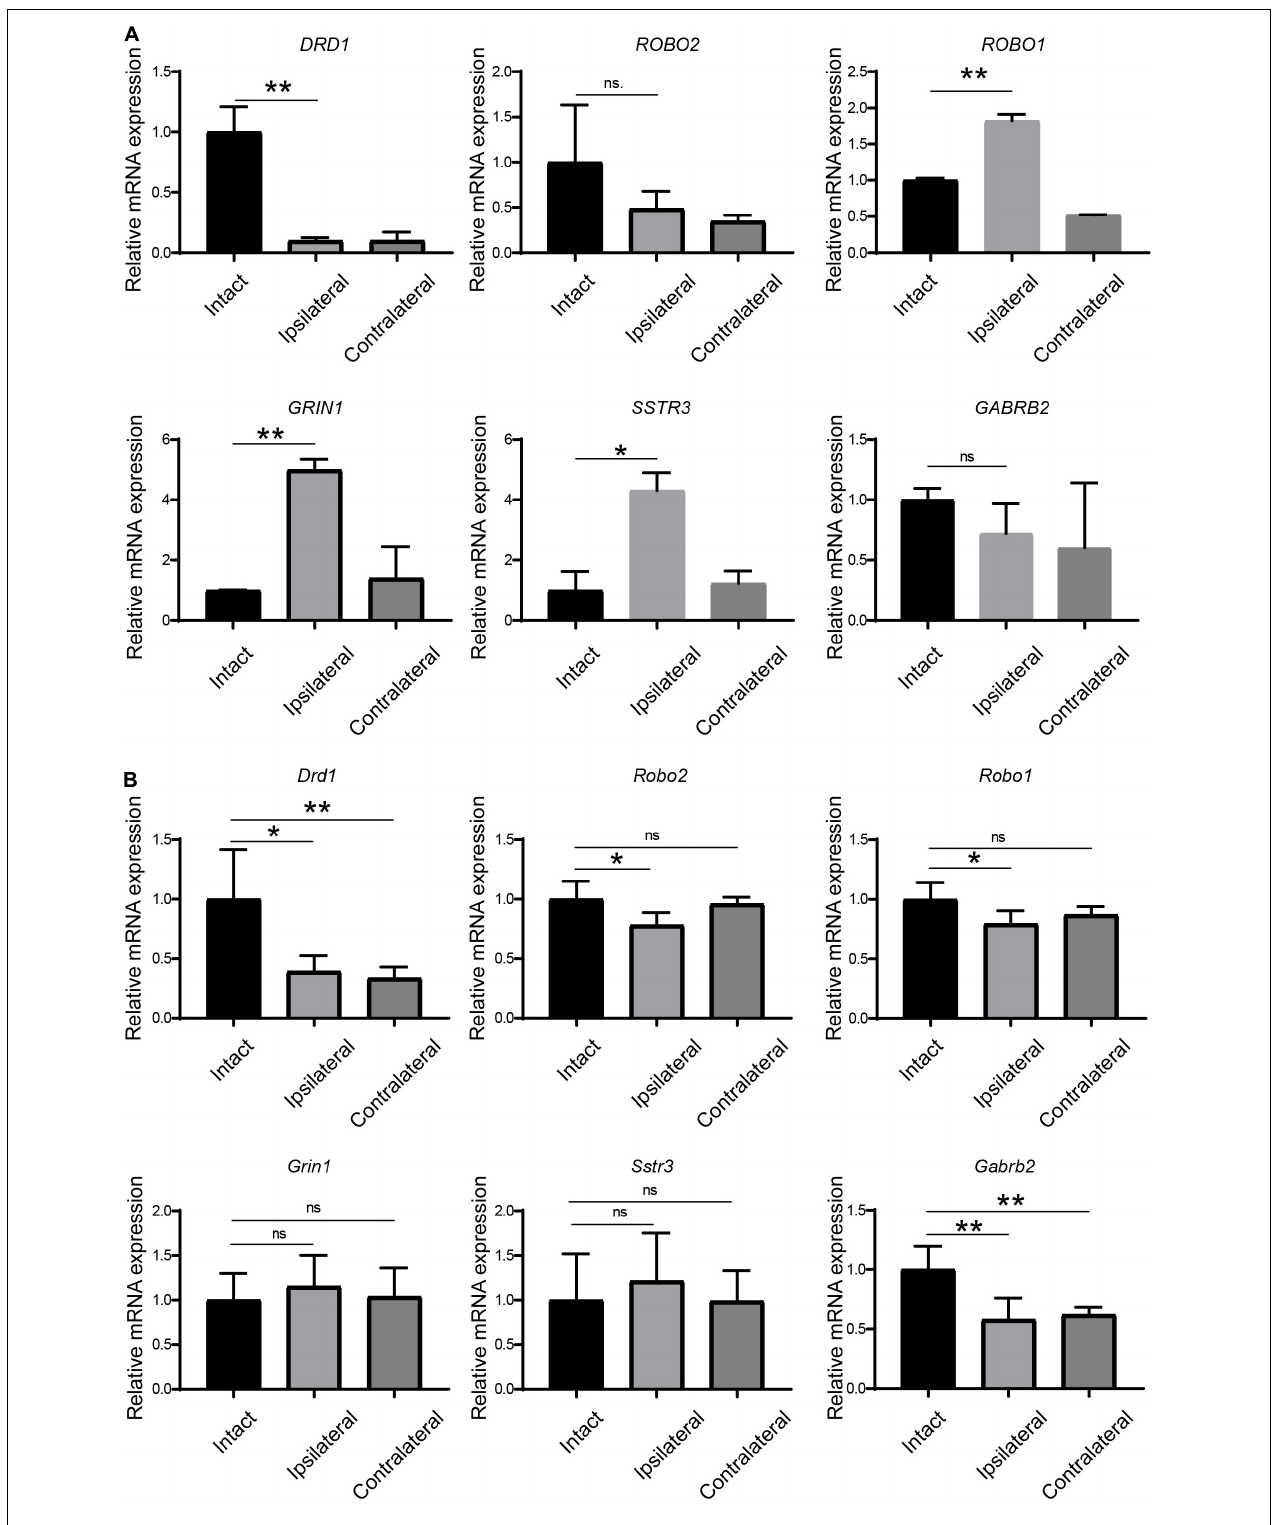
FIGURE 3 | Verification of the regulation of receptors in LGN samples from amblyopia models by qPCR. (A) Verification in the monkey model of amblyopia. (B) Verification in the mouse model of amblyopia. Data represent the mean ± SE. n = 3 for (A) and n = 5 for (B) in all groups, * p < 0.05, ** p < 0.01.